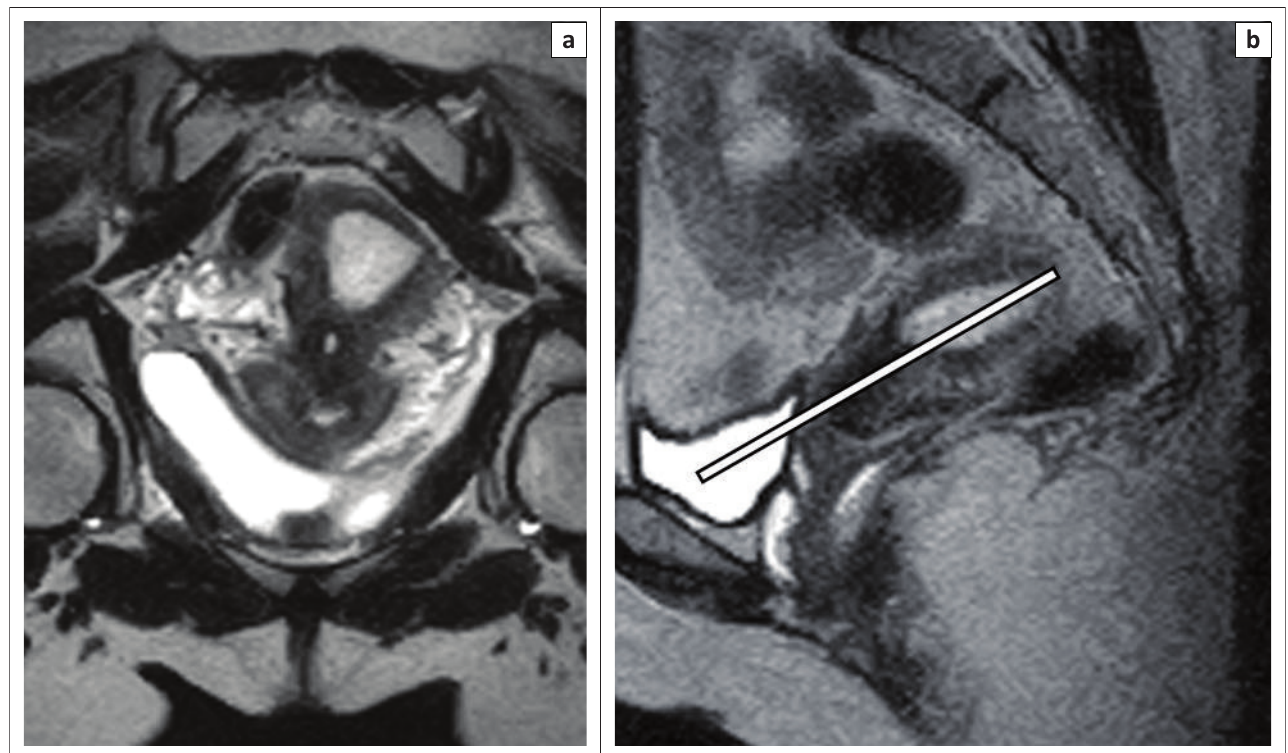
FIGURE 1: Oblique coronal image (a) obtained by planning along the long axis of uterus (white line) on the sagittal T2 sequence